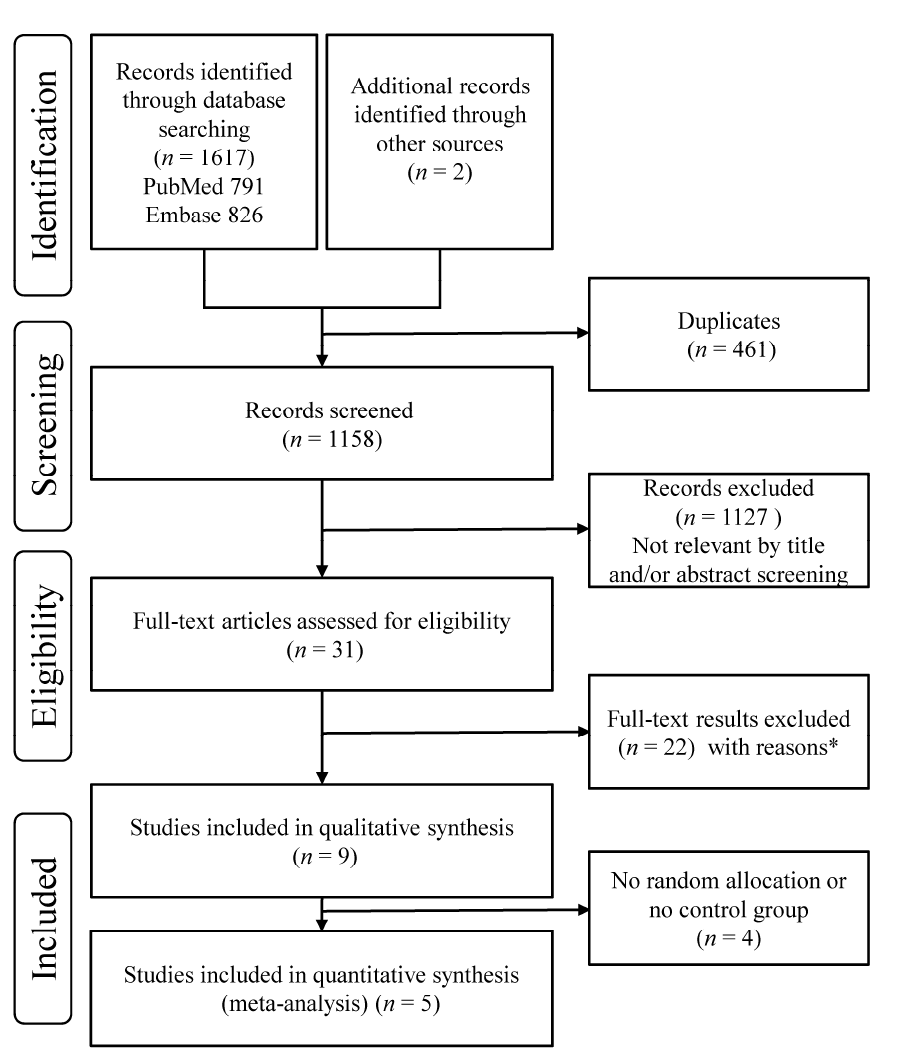
Figure 1. Preferred Reporting Items for Systematic Reviews and Meta-Analyses (PRISMA) flow information diagram used to select studies on the effect of exercise on quality of life in patients with systemic lupus erythematosus. * Full-text articles were excluded for the following reasons: review articles ( n = 8), not clinical trials ( n = 8), did not measure quality of life ( n = 3), not in English ( n = 1), a qualitative study ( n = 1), and a letter ( n =